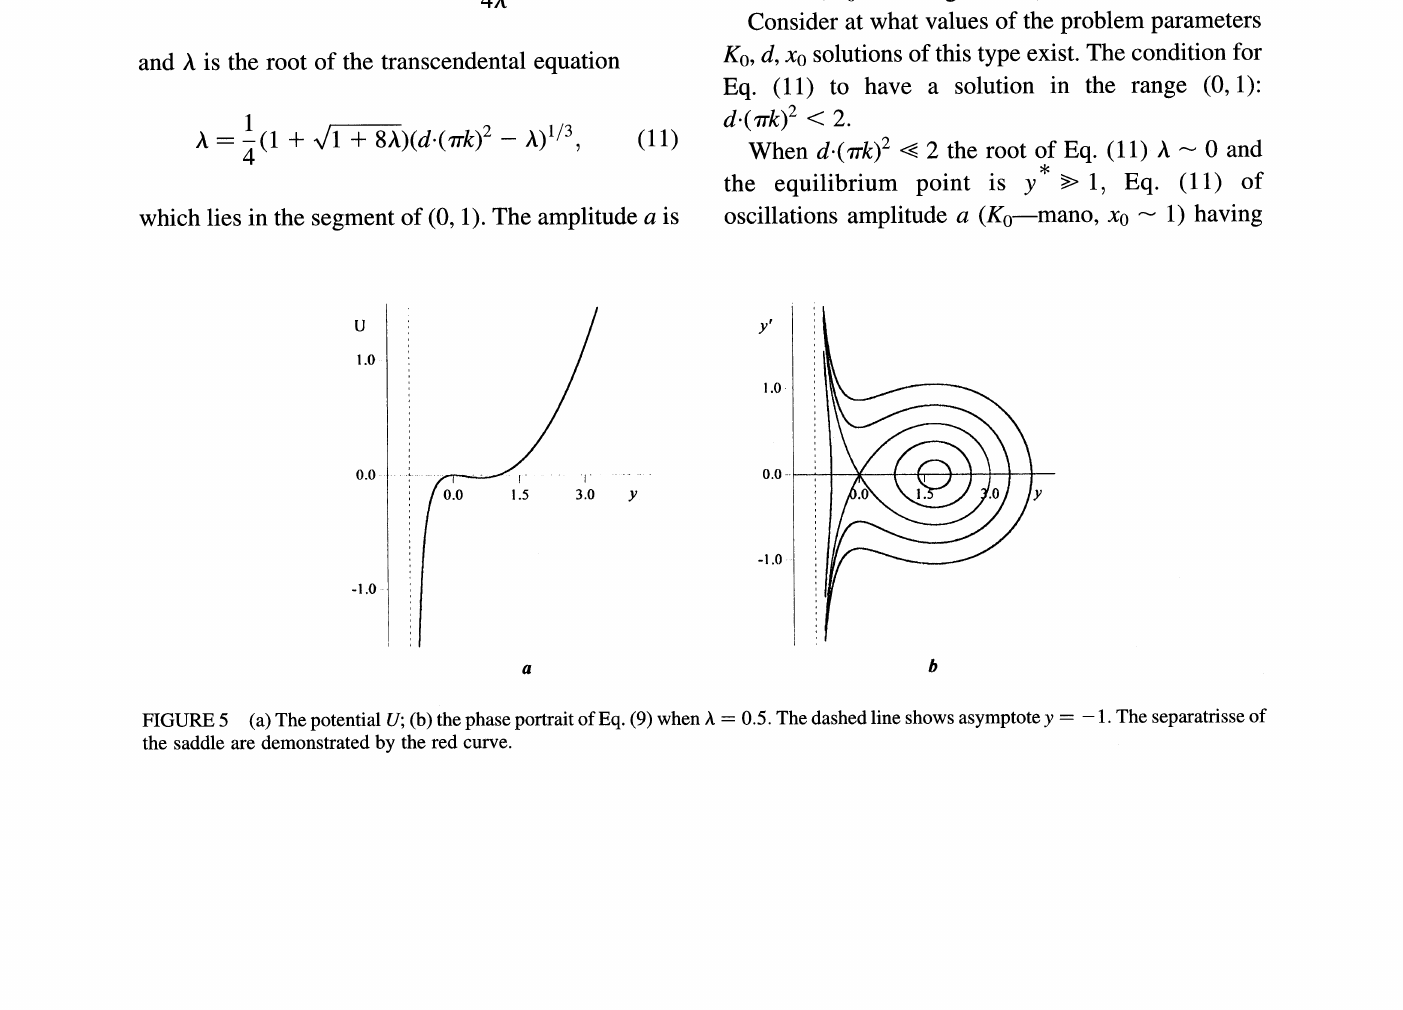
FIGURE 4 (a) the potential U; (b) The phase portrait of Eq. (9) when A 2. The dashed line shows asymptote y 1. The separatrisse of the saddle are demonstrated by the red curve.